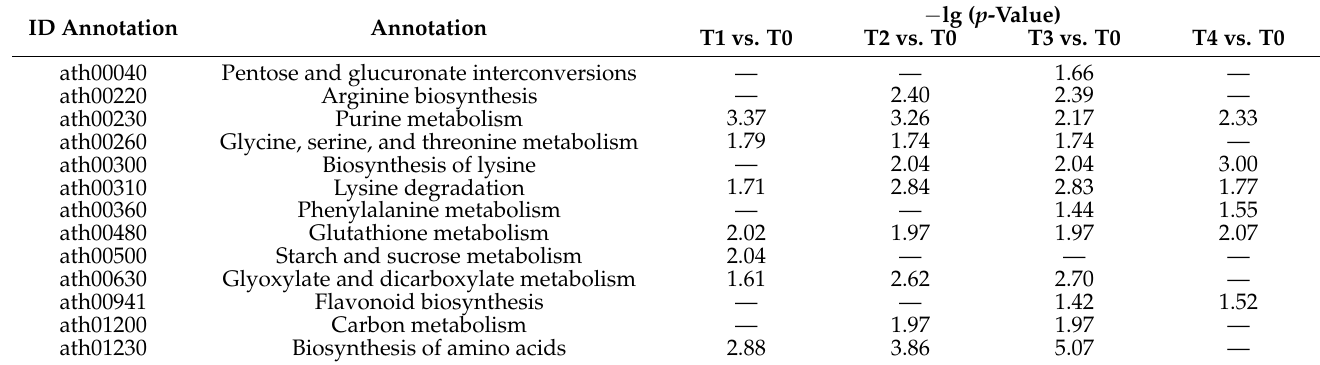
Table 4. Significantly different metabolic pathways under different fertilization